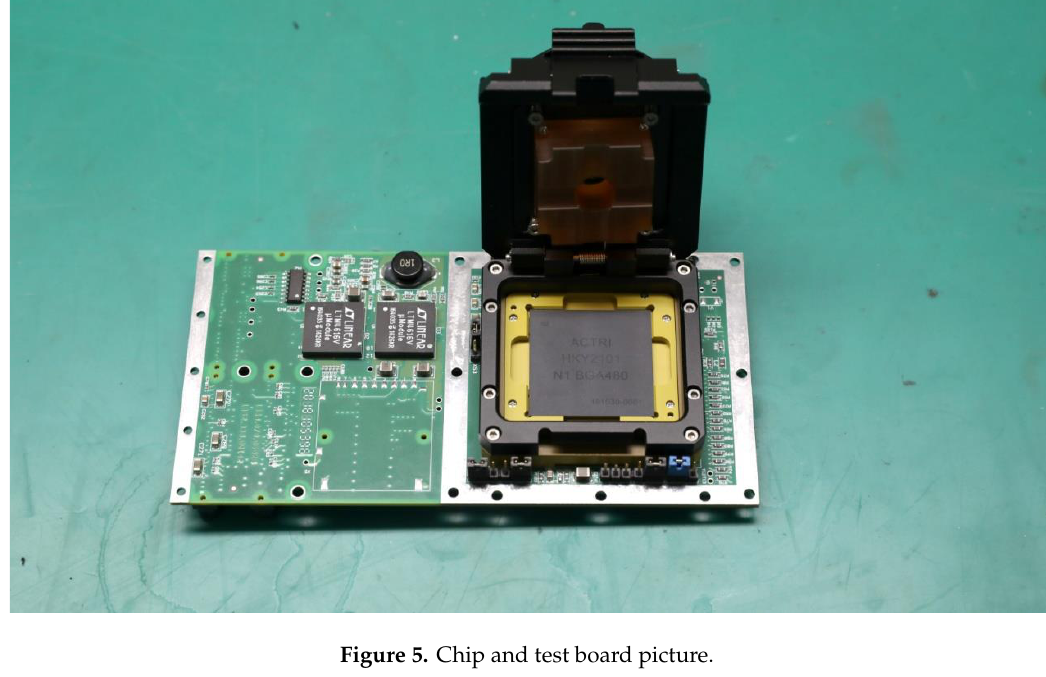
Figure 5. Chip and test board picture. Electronics 2020 ,9,x; doi: FOR PEER REVIEW